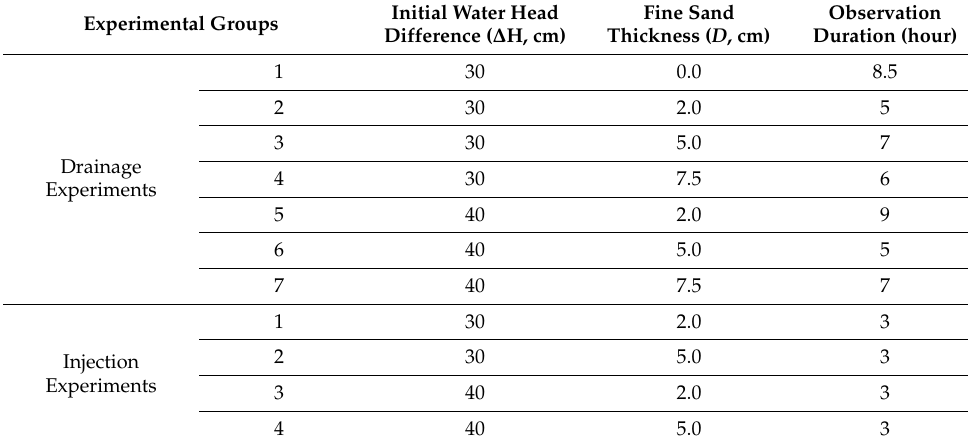
Table 1. Main parameters of different